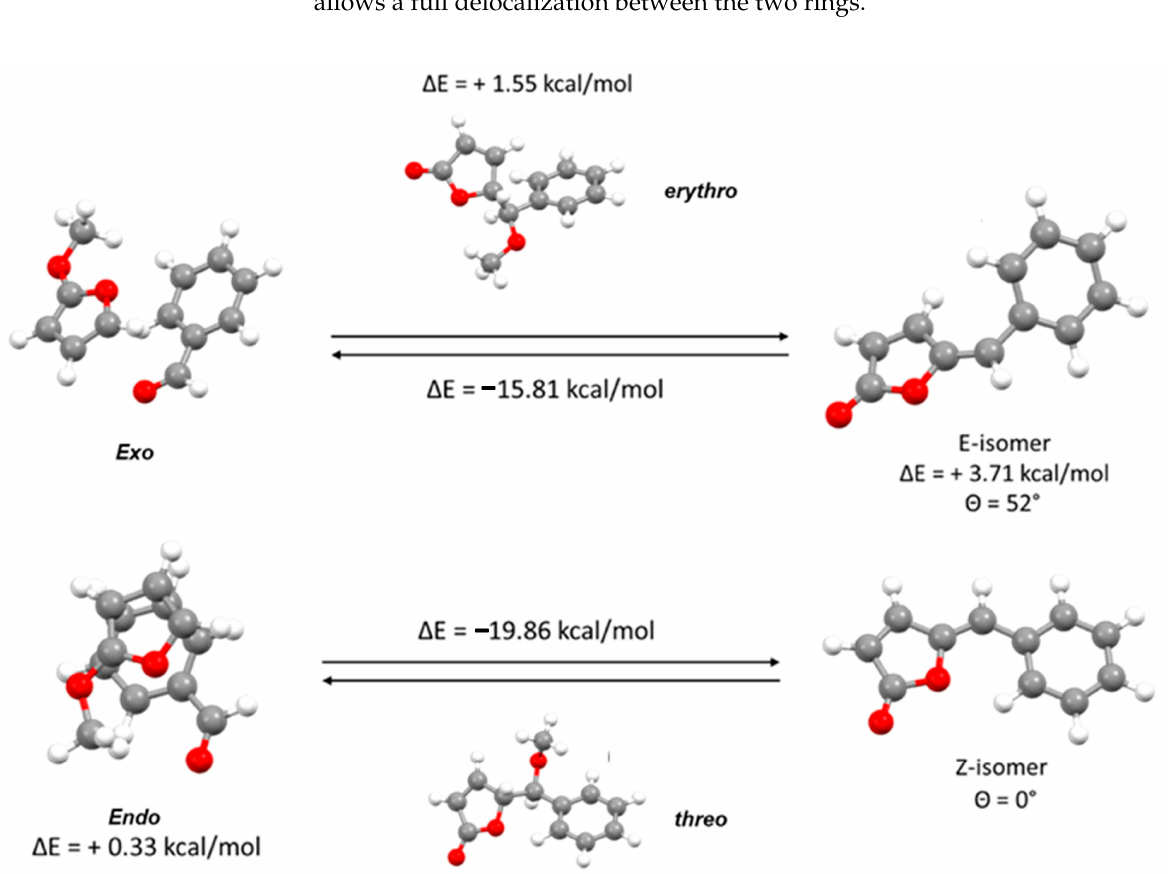
Figure 3. Density functional theory quantum mechanical calculations.